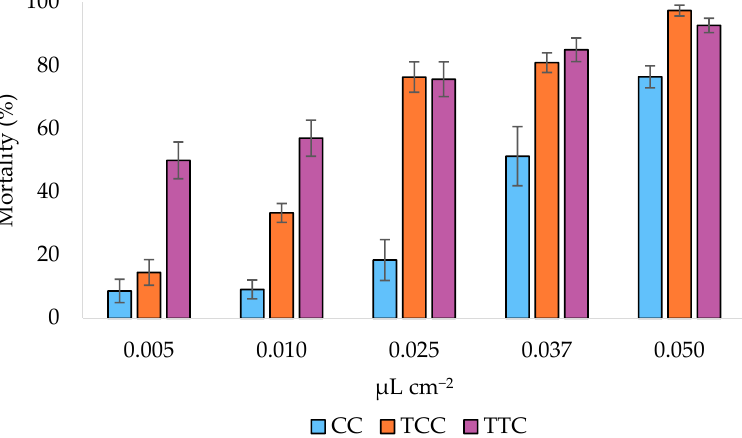
Figure 3. Ovicidal activity of the essential oils of the carvacrol (CC), thymol/ p -cymene (TCC), and thymol/ γ -terpinene (TTC) oregano chemotypes. The histograms represent the mean mortality percentage (%). Bars represent standard errors.